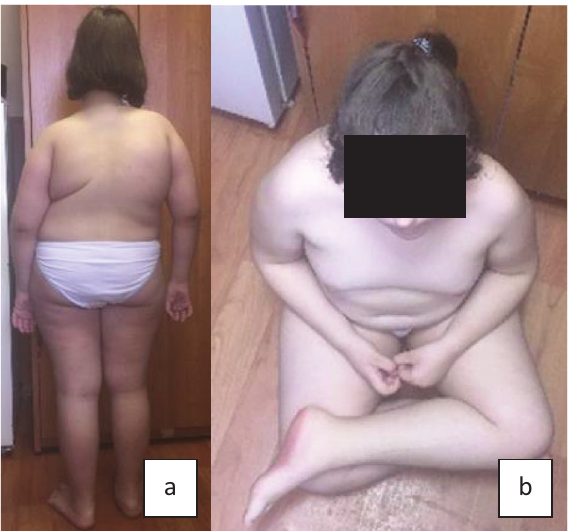
Figure 1. Proband no. 3: а ) thoracolumbar dextroscoliosis of the 3 rd degree; b) joint hypermobility, obesity of the 1 st /2 nd degree.